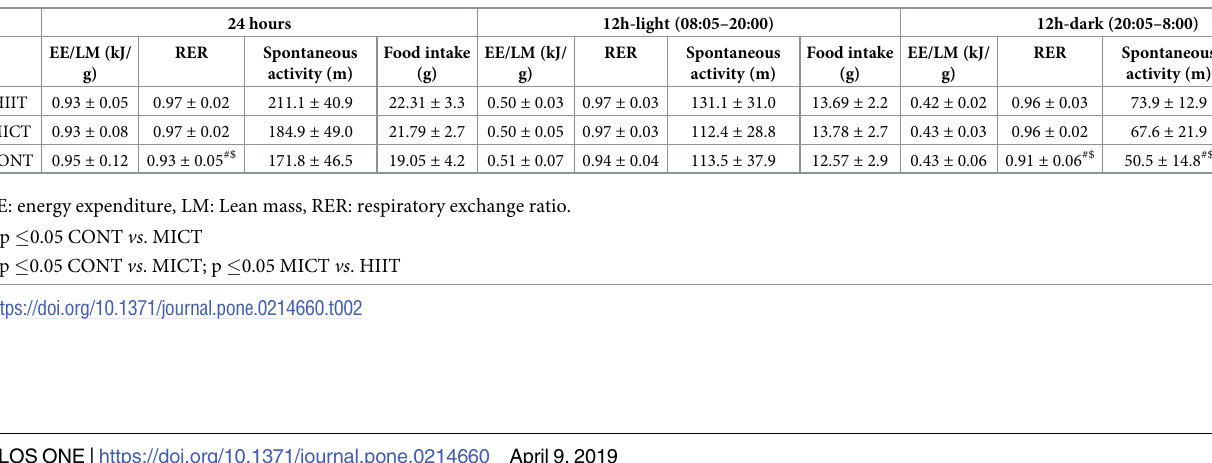
Table 2. Indirect calorimetry results after 10 weeks of training (mean ±